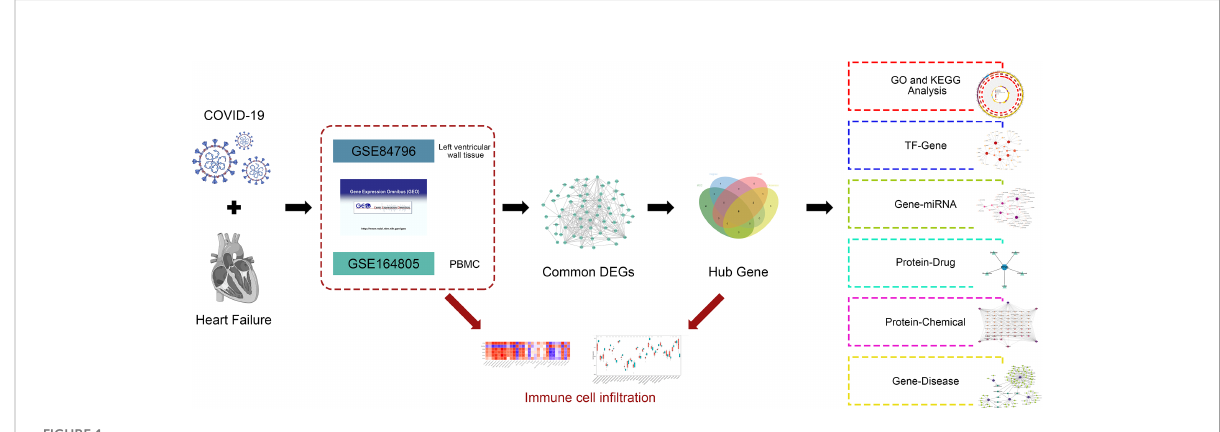
FIGURE 1 Schematic diagram of the work fl ow in this